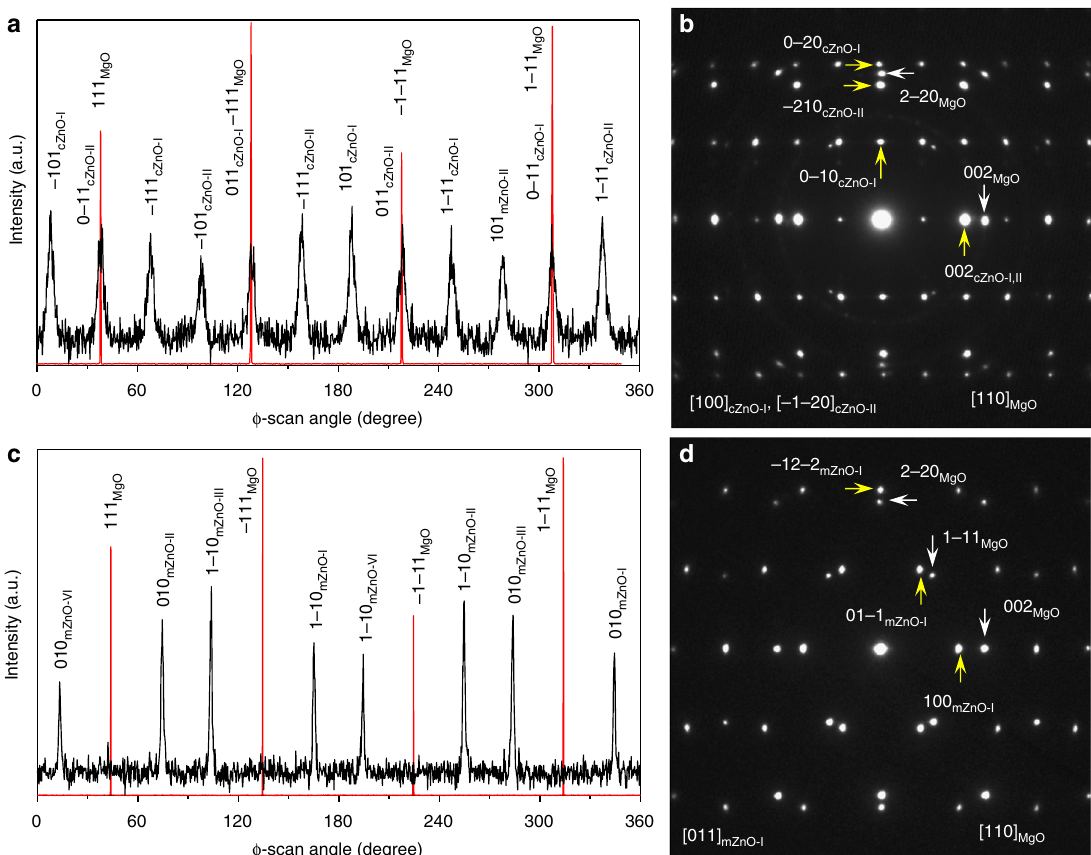
Fig. 3 Orientation relationship for c-ZnO and m-ZnO. a X-ray diffraction (XRD) ϕ scan and ( b ) Electron diffraction pattern (EDP) from the c-ZnO fi lm. The XRD ϕ -scan is carried out with 2 θ = 37°, χ = 54.7° for MgO and 2 θ = 36.2°, χ = 61.6° for c-ZnO. The EDP consists of three sets of patterns: [110] MgO , [100] cZnO-I and [ − 1 − 20] c-ZnO-II (subscripts MgO, cZnO-I, and cZnO-II represent MgO substrate, c-ZnO domain I and II, respectively). c XRD ϕ -scan and ( d ) [011] zone EDP from the m-ZnO fi lm. Subscripts MgO, mZnO-I, mZnO-II, mZnO-III, and mZnO-VI represent MgO, m-ZnO domains I, II, III, IV, respectively. The XRD ϕ -scan is carried out with 2 θ = 37°, χ = 54.7° for MgO and 2 θ = 31.7°, χ = 60° for 010 mZnO-II and 1 – 10 mZnO-II with subscript mZnO-II representing m-ZnO domain II) deviate from the 111 MgO peak by 31° and 211°, respectively, indicating that [010] mZnO-II is parallel to [140] MgO . Actually, the m-ZnO-II is rotated 90° along [210] ZnO direction (the normal of (001) plane) in terms of m-ZnO-I. In this case, the ZnO [08 – 3] is parallel to MgO [110]. Therefore, when the incident beam is along the MgO [110] direction, the m-ZnO- II would be viewed along a high index zone ([08 – 3] mZnO-II ) in which the projected distances among the atoms along [011] mZnO- II (vertical direction) are too close to be resolved. In this way, the streak-like pattern with a spacing of about 0.262 nm is formed.